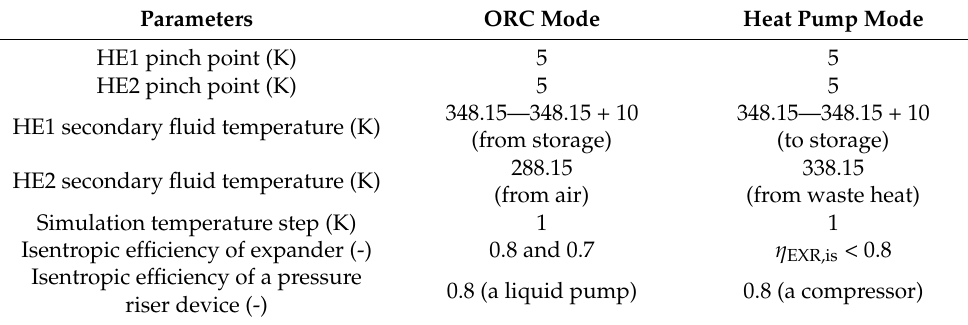
Table 2. The reversible Rankine-based thermodynamic cycle (RRTC) setup applied in this study. Parameters ORC